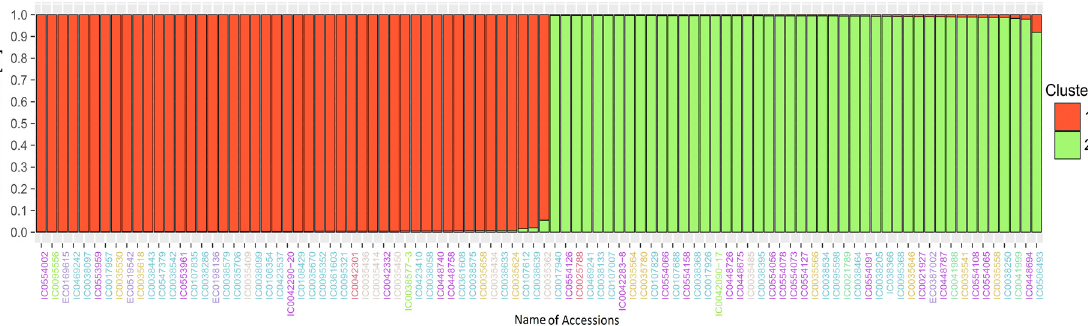
Figure 4. Bar plot generated by population structure analysis of 94 A. hypochondriacus accessions based on K = 2. The name of accessions in different colors represents their different states of origin.